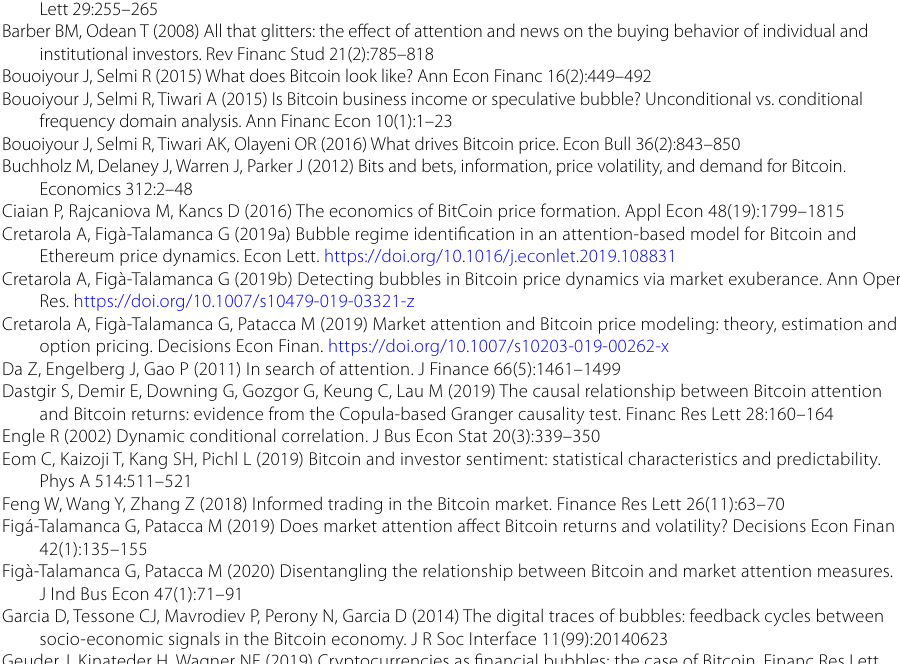
Figá-Talamanca G, Patacca M (2019) Does market attention affect Bitcoin returns and volatility? Decisions Econ Finan 42(1):135–155 Figà-Talamanca G, Patacca M (2020) Disentangling the relationship between Bitcoin and market attention measures. J Ind Bus Econ